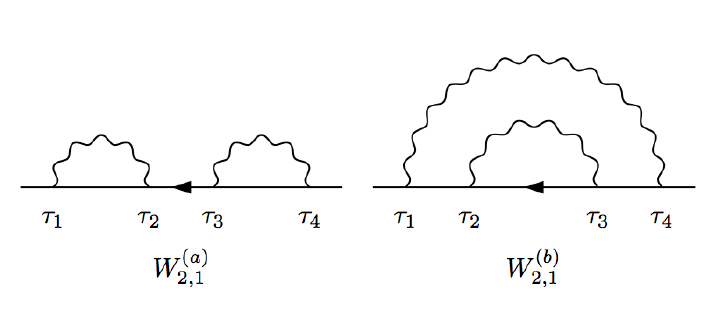
+ W ( b ) with path-ordered four 2 ; 1 2 ; 1